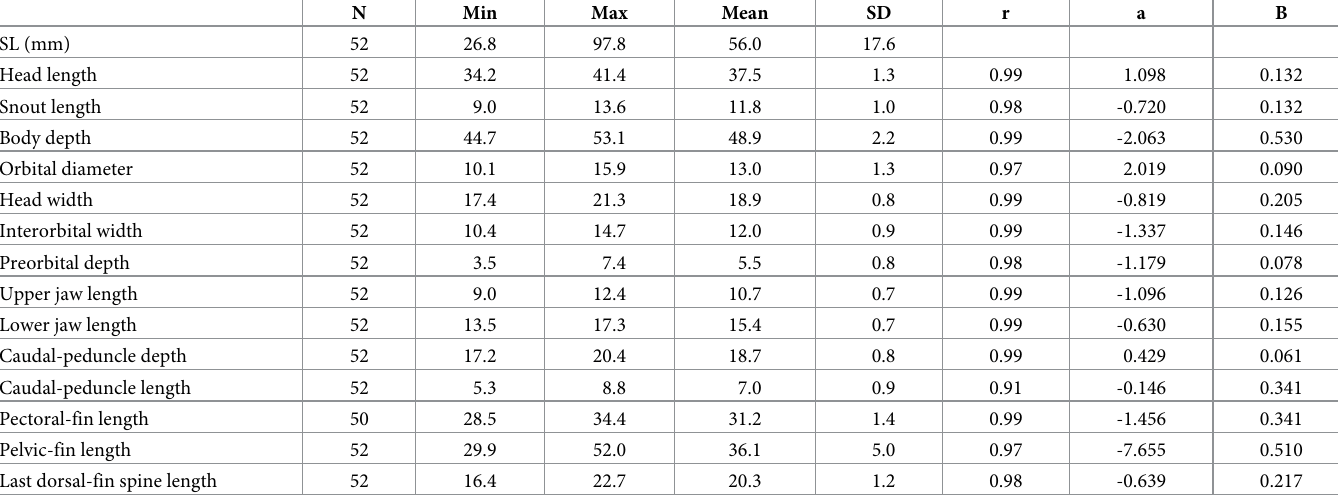
Table 15. Australoheros ipatinguensis . Size (SL), proportional measurements (per cent of SL), and linear regression parameters. N